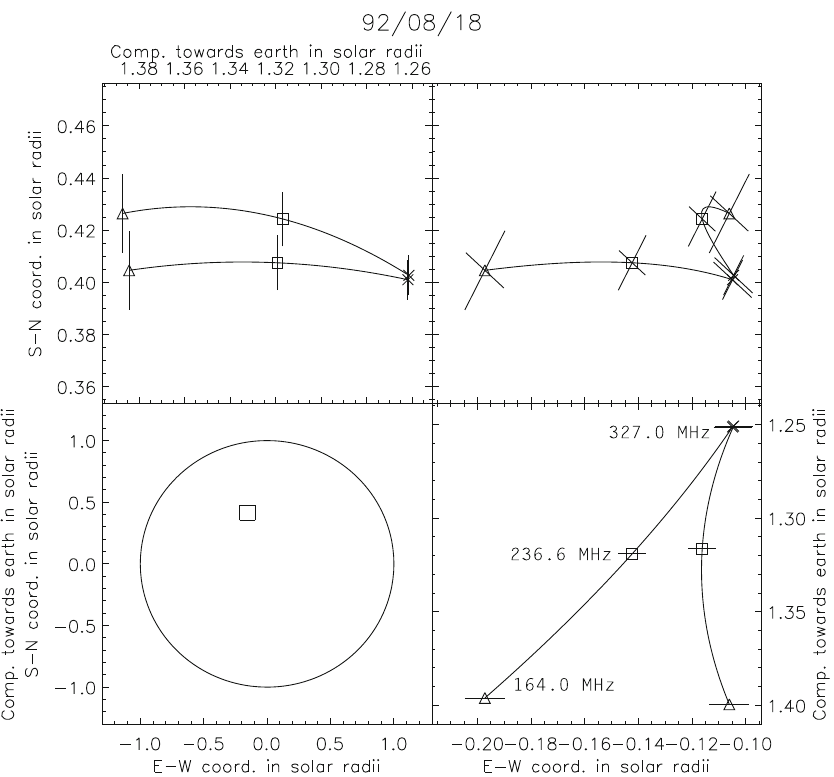
Fig. 21 Reconstructed trajectories of two radio events involving type III bursts and spikes, both of the kind often observed at meter wavelength. Upper right positions with error bars observed by the Nancay Radio Heliograph at three frequencies. The symbols represent the observed frequencies: cross sign for 327.0 MHz, open square for 236.6 MHz, and open triangle for 164.0 MHz. Bottom left Position of the radio emissions on the Sun. The small square indicates the size of the image presented in the upper right image . Upper left projection of the sources on the meridian plane relative to Earth (as seen by an observer West of the source). Lower right the radio sources projected on the equatorial plane, showing the view of an observer North of the Sun). In both graphs the trajectories have been 3-dimensionally spline interpolated to outline the trajectory. Image reproduced by permission from Paesold et al. (2001), copyright by